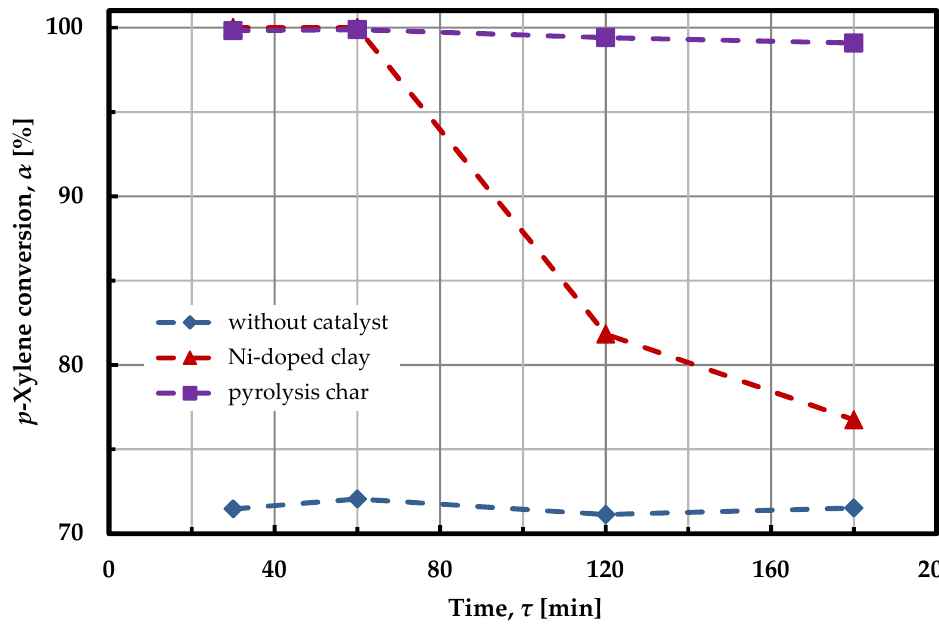
Figure 2. Variation of p -xylene conversion with time for experiments carried out at 800 °C using 10 g of catalyst. Non-catalytic (diamonds), Ni-doped clay- (triangles) and pyrolysis char- (squares) catalyzed decomposition of model tar component.